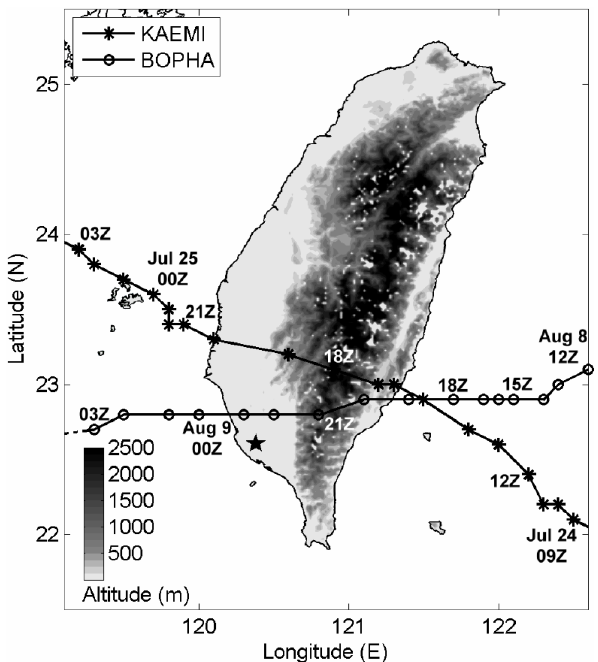
Figure 1. Topography of Taiwan and tracks of two typhoons KAEMI (200605) and Fig. 1. Topography of Taiwan and tracks of two typhoons KAEMI BOPHA (200609) along with the wind-profiler location indicated by star (200605) and BOPHA (200609) along with the wind-profiler loca- symbol. tion indicated by star